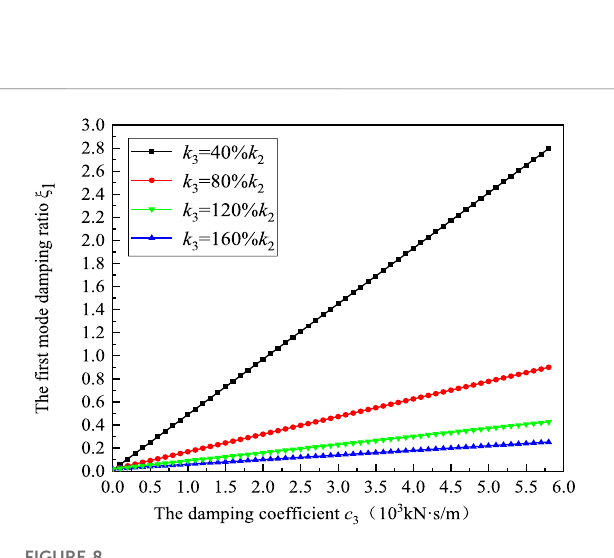
FIGURE 7 The equivalent system of damping vibration isolation simpli fi ed model.